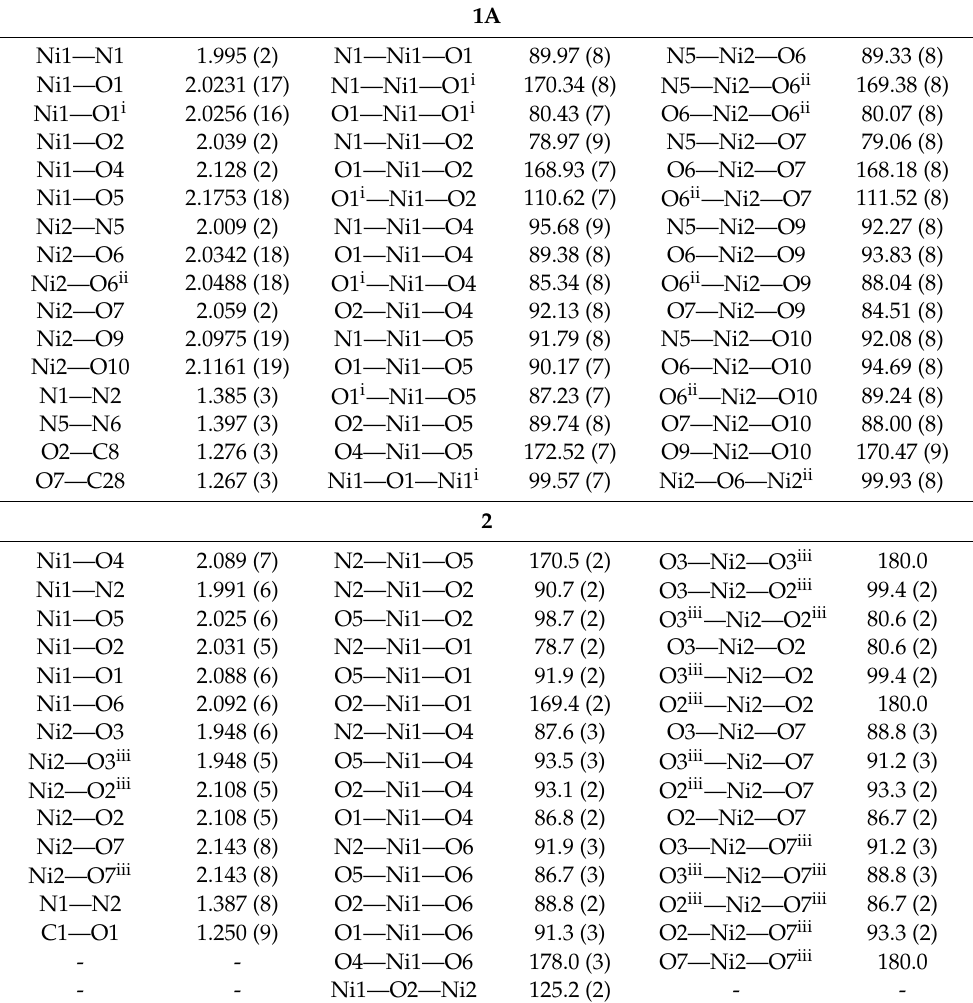
Table 2. Selected bond distances (Å) and angles ( ◦ ) in complexes 1A and 2 .